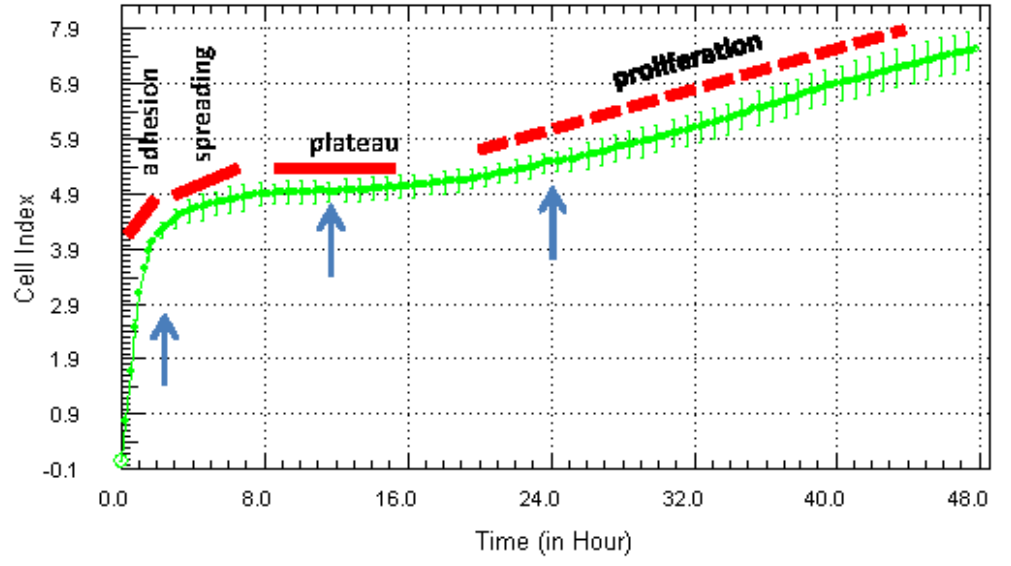
Figure 2. Interpretation of xCELLigence biosensor Cell Index curves: determination of assay parameters influencing experimental design. After obtaining a standard Cell Index adhesion curve for a particular cell type, it can be used to interpret specific behaviours of the cells relevant to the experimental design. Using the HMEC-1 endothelial cells as an example, the initial period of the Cell Index curve reveals the initial phase of cell adhesion and spreading (0–8 h), followed by a plateau phase prior to a gradual period of proliferation. The arrows represent potential time points for drug treatment; note that the behaviour or response of the cells may vary at each. The curve represents the mean Cell Index value from >4 wells ±